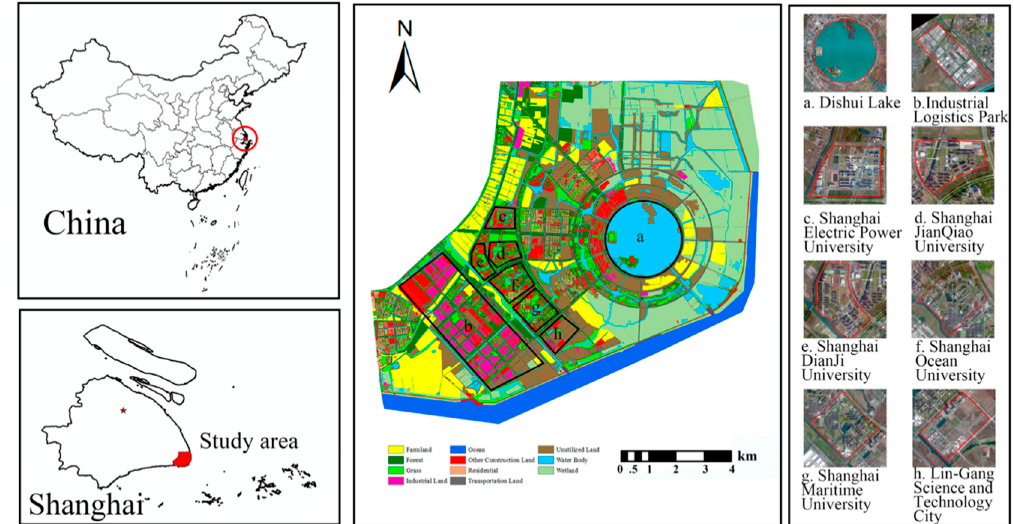
Figure 1. Location of the Lin-Gang core area.